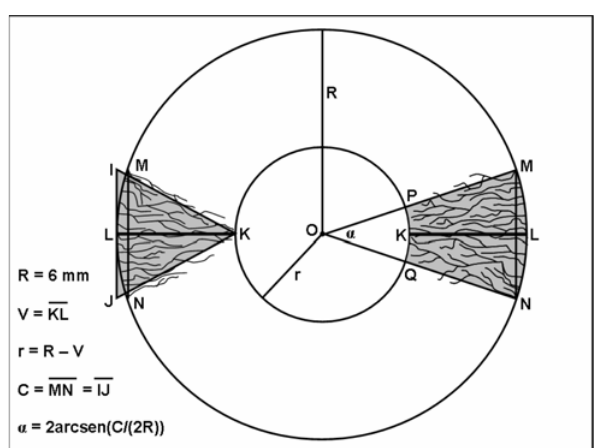
FIGURA 2 – Desenho esquemático do círculo corneano, cujo raio ( R ) é igual a 6 mm, mostrando a região de angiogênese, bem como os parâmetros utilizados na sua quantificação. O segmento MN corresponde à corda ( C ) da circunferência corneana que delimita a região de neovascularização. KL corresponde ao comprimento vascular